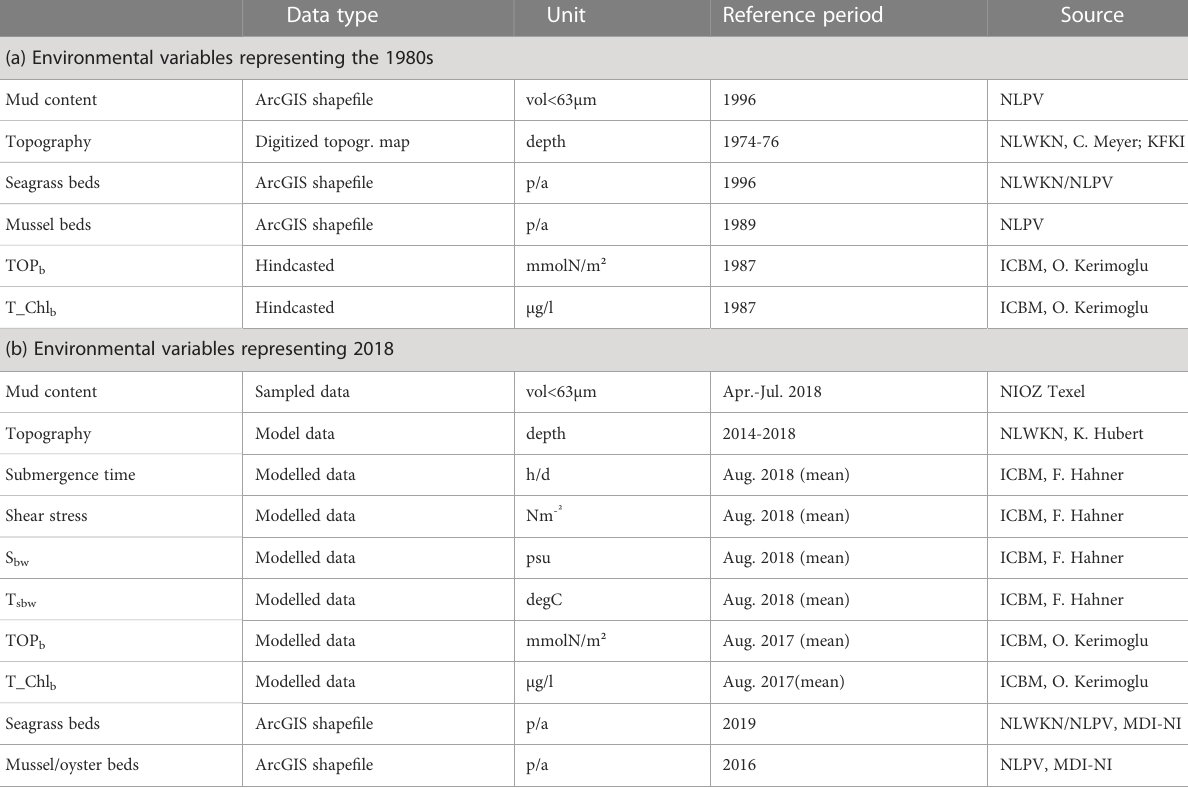
TABLE 1 Environmental variables and associated information for (A) the 6 environmental variables employed for our 1980s community analysis and (B) the 10 environmental variables employed for our 2018 community